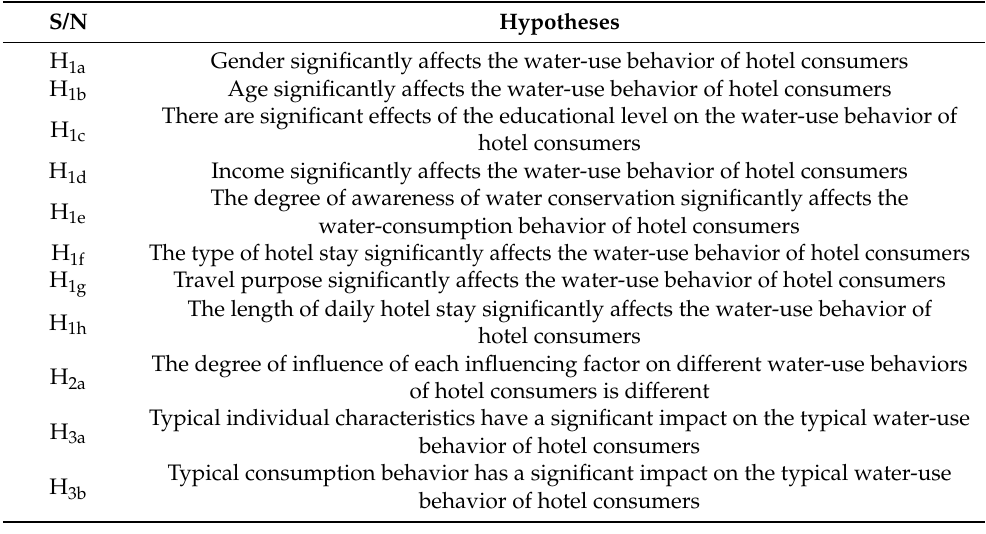
Table 2. Research hypotheses.